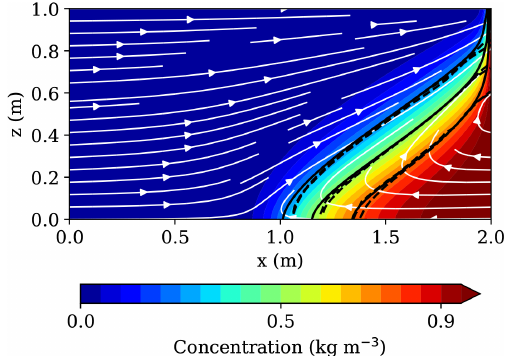
Figure 4. Comparison of TRANSE simulation results for the Henry problem (solid lines and contours) against 0.25, 0.5 and 0.75 isochlors computed with FEFLOW and ROCKFLOW (dashed) by Kolditz et al. (1998). White streamlines illustrate the spatial velocity field.